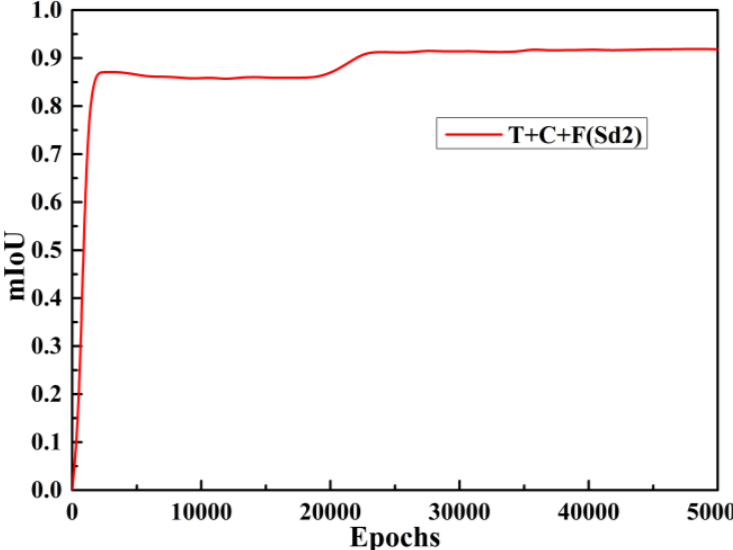
Figure 7. Example of mIoU curve .